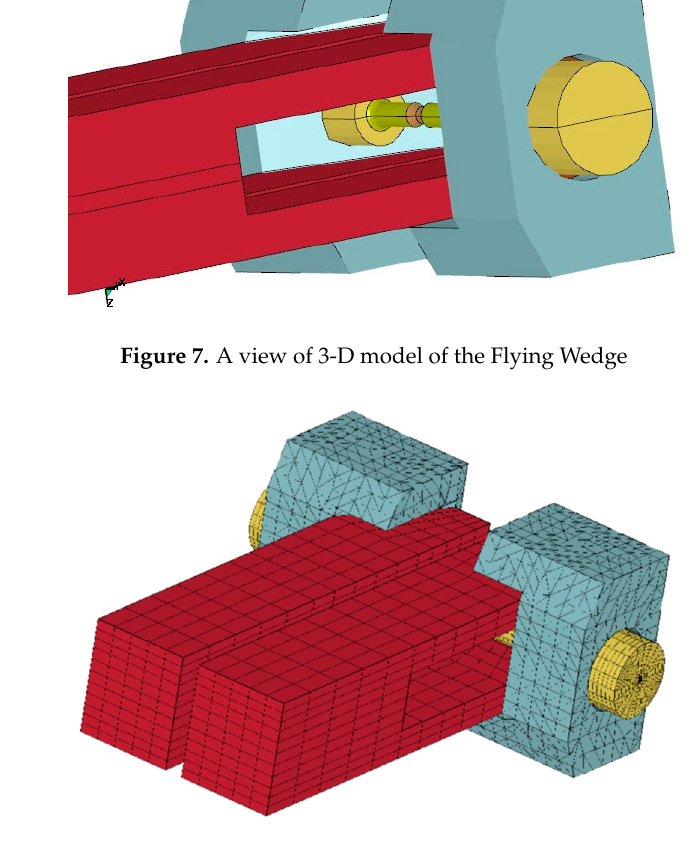
Figure 8. A view of finite element model of the Flying Wedge.